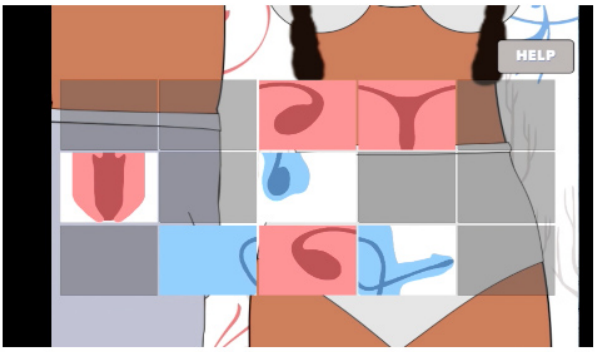
Figure 1. Screenshot 1: From the minigame attached to the Having Children milestone. Note the HELP button in the upper